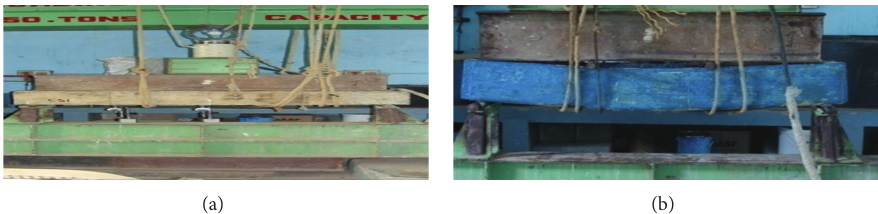
Figure 6: (a) Two pint loading system on a 50 ton loading frame; (b) loading on fully wrapped beam with woven jute FRP.